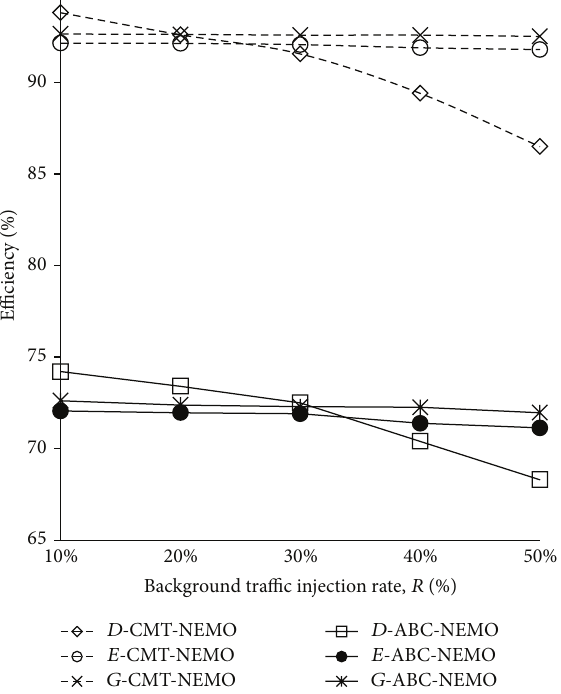
Figure 23: A comparison of gross transmission efficiency, effective transmission efficiency, and distortion efficiency for each